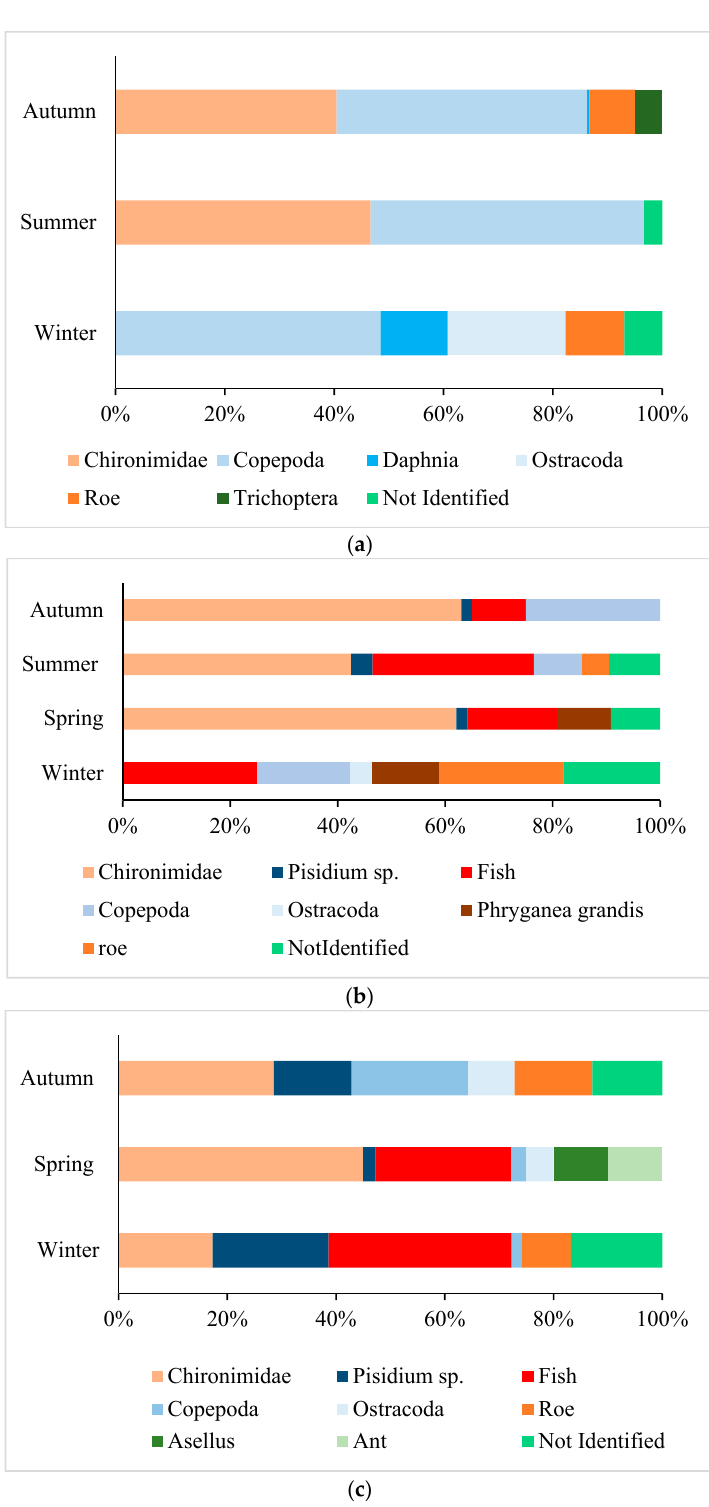
Figure 2. Seasonal variation in stomach content of ( a ) E. smelt (Winter n = 13; Summer n = 6; Autumn n = 12); ( b ) A. charr (Winter n = 8; Spring n = 12; Summer n = 10; Autumn n = 11); ( c ) Whitefish (Winter n = 11; Spring n = 4; Autumn n = 7).